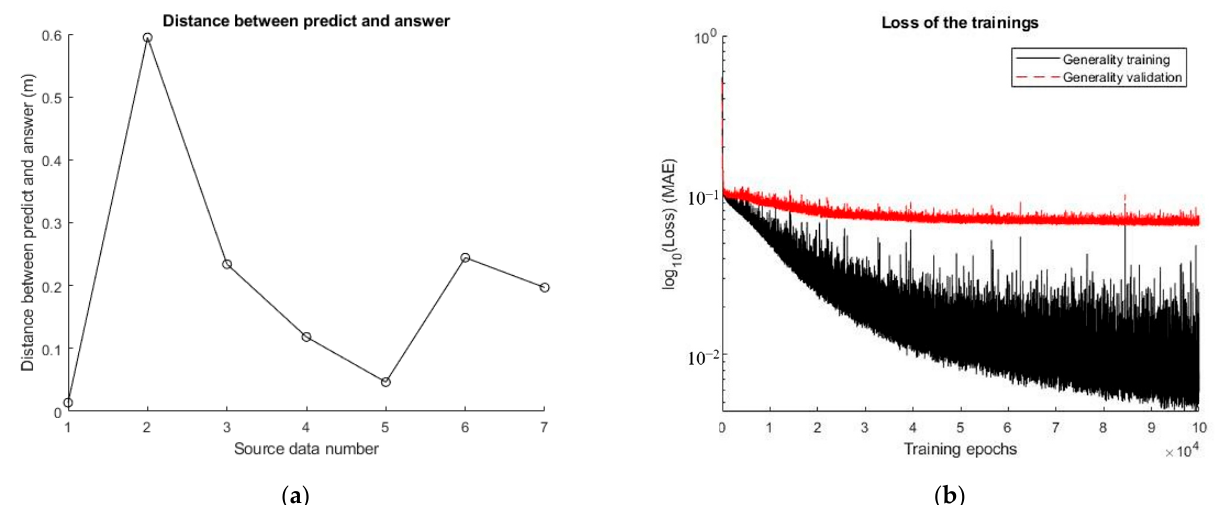
Figure 19. ( a ) Prediction results obtained in the universal applicability test. ( b ) Verification training epoch obtained in the universal applicability test. Table 1. Prediction results obtained by combining the data of the rectangular cuboid model and large cavitation tank model.